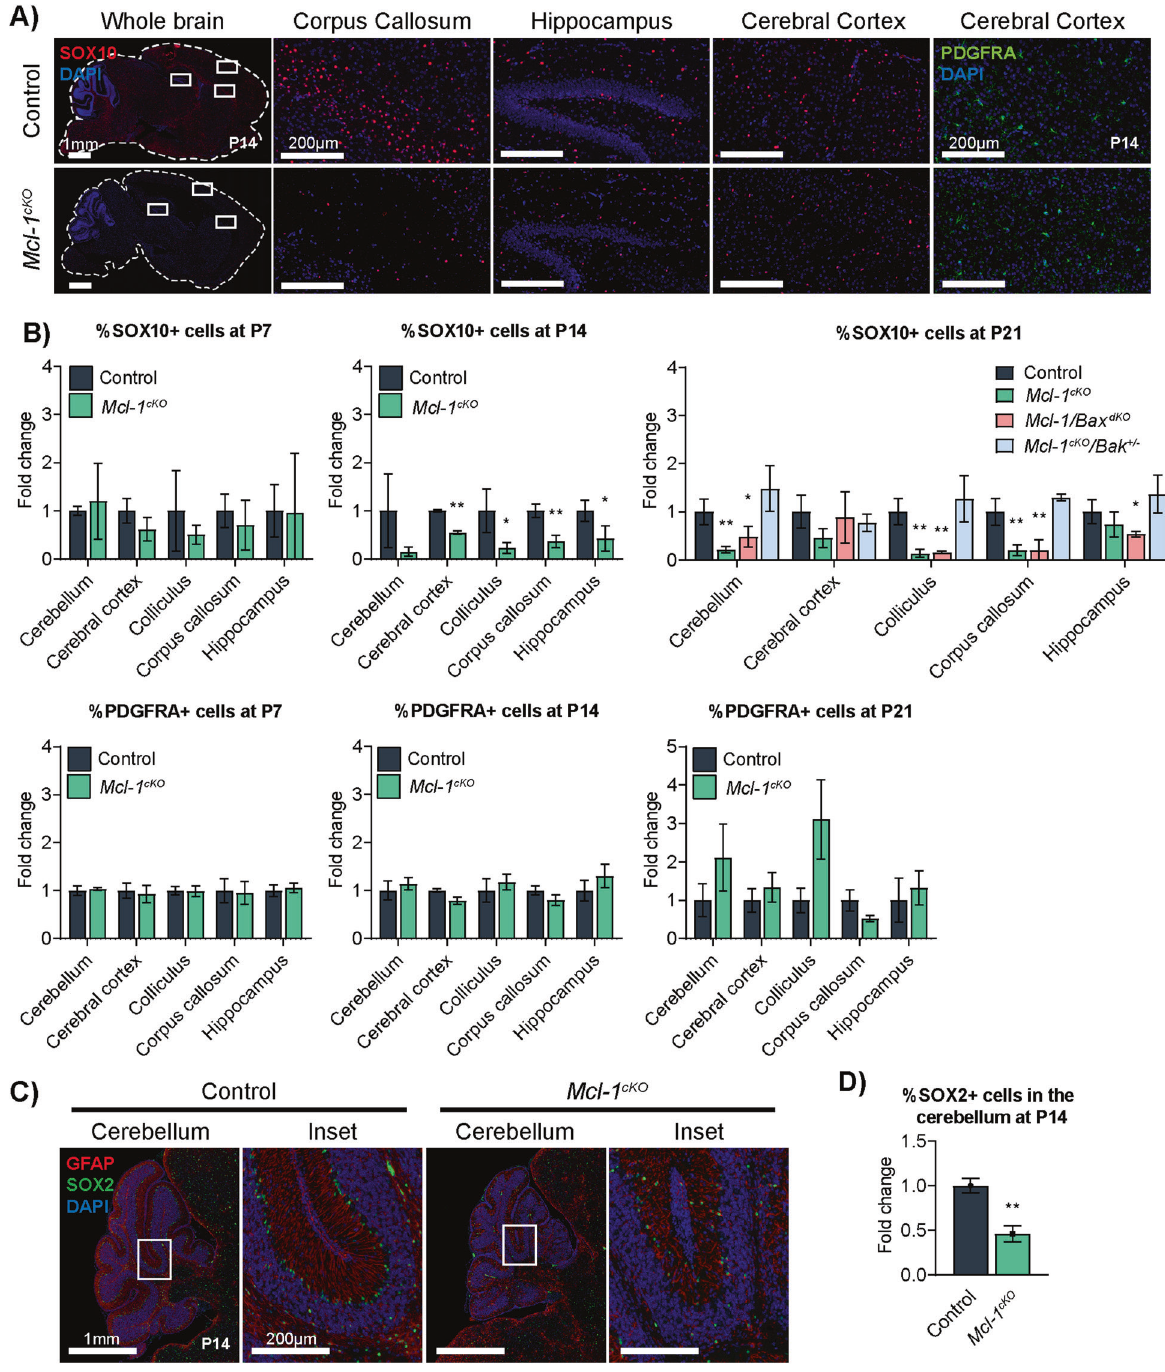
Fig. 5 Mcl-1 deletion causes loss of oligodendrocytes and Bergmann glia that is rescued with regional variation by co-deletion of Bak or Bax . A , B Representative images and quanti fi cation of SOX10 and PDGFRA IHC in the indicated genotypes. C Representative immuno fl uorescence for GFAP and SOX2 IHC identify Bergmann glia in P14 mice of the indicated genotypes. D SOX2 + cells are signi fi cantly reduced in Mcl-1 cKO mice. * and ** denote p < 0.05 and p < 0.01, respectively, relative to controls. Mcl-1 deletion causes neuroin fl ammation Brains of Mcl-1 cKO mice contained increased cells expressing the myeloid marker IBA1 (Fig. 7A), indicating microglial activation [34, 35]. The microglial changes in Mcl-1 cKO mice began later than the astrocytic and oligodendrocytic changes, beginning at the corpus callosum at P14; by P21, Mcl-1 cKO mice showed increased IBA + cells in diverse brain regions (Fig. 7B). The increased IBA1 + microglia in Mcl-1 cKO mice demonstrates a non-cell autonomous Cell Death and Disease (2021)